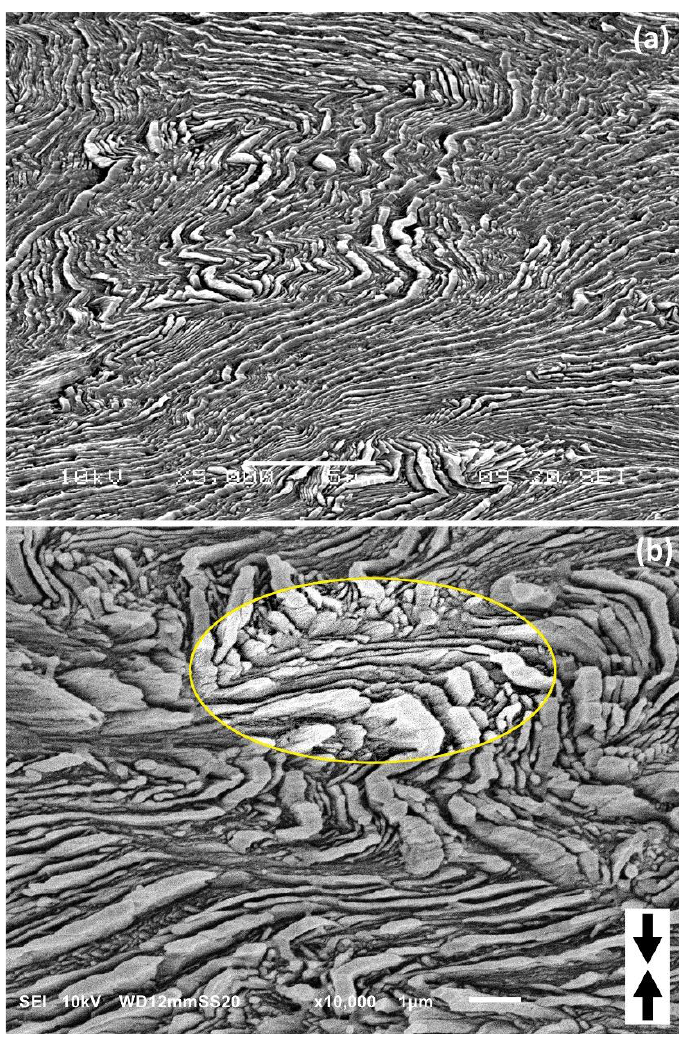
Figure 11. SEM micrographs of the H3-CE samples deformed by uniaxial compression to the true strain of e = 1.6 ( a ), e = 1.4 ( b ). The direction of compression is vertical. Samples were etched prior to observation.